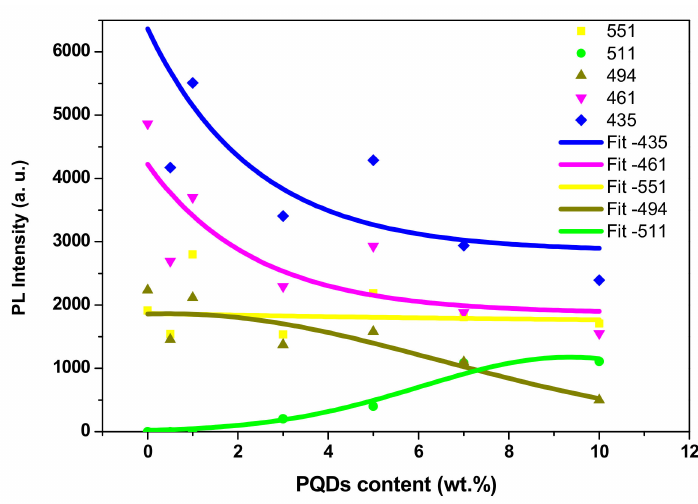
Figure 10. PL intensity of the MEH–PPV/PFO hybrid as a function of the PQDs content at 435, 461, 494, 511, and 551